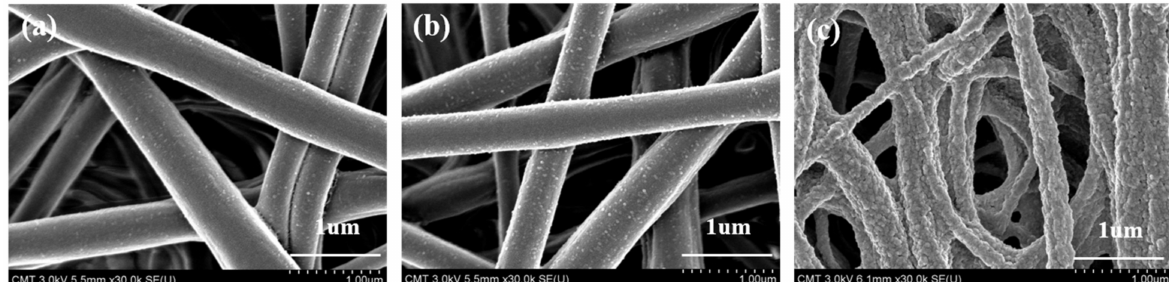
Figure 4. Scanning Electron Microscopy (SEM) images of cellulose acetate (CA) electrospun mem- brane ( a ), regenerated cellulose (RC) membrane ( b ) and PVCL modified RC membrane ( c